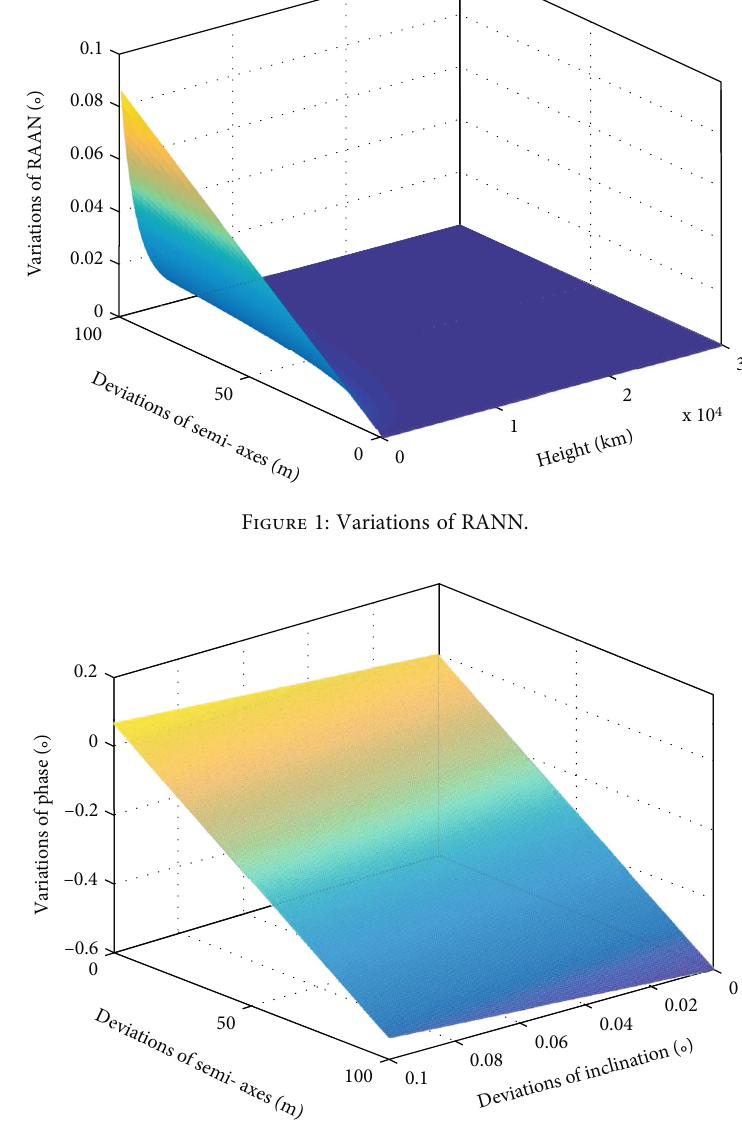
Figure 2: Variations of